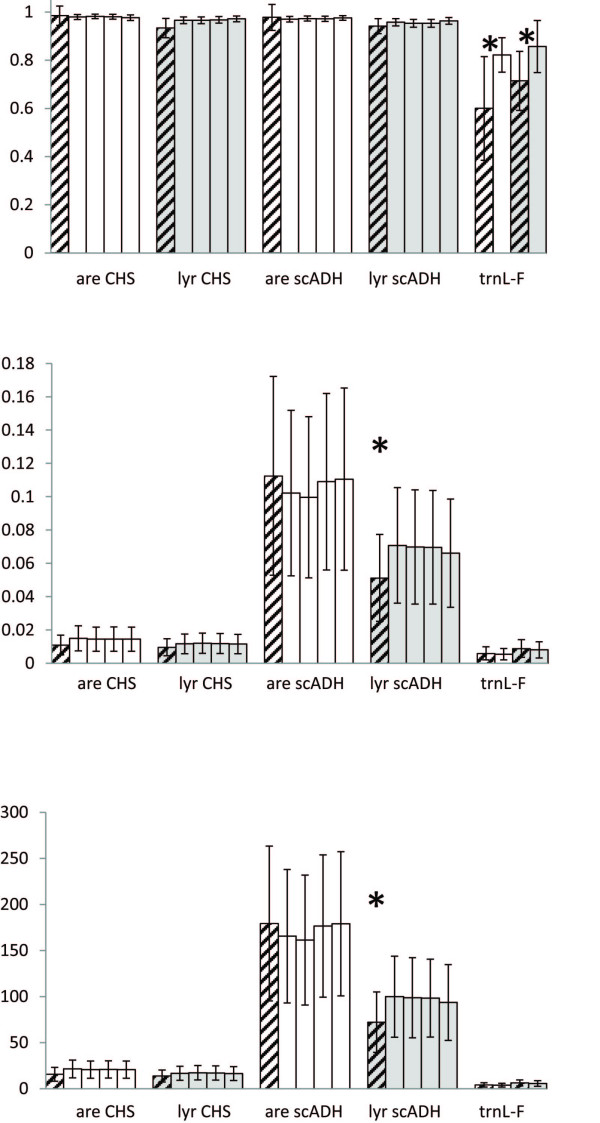
Diversity analyses of Central European Arabidopsis arenosa (white) and A. lyrata (grey). Diploids are hatched, tetraploids are blank. Bars give standard deviation, * gives significance. (a) Gene diversity, Ĥ; (b) Nucleotide diversity, π; and (c) Average number of nucleotide differences, k.